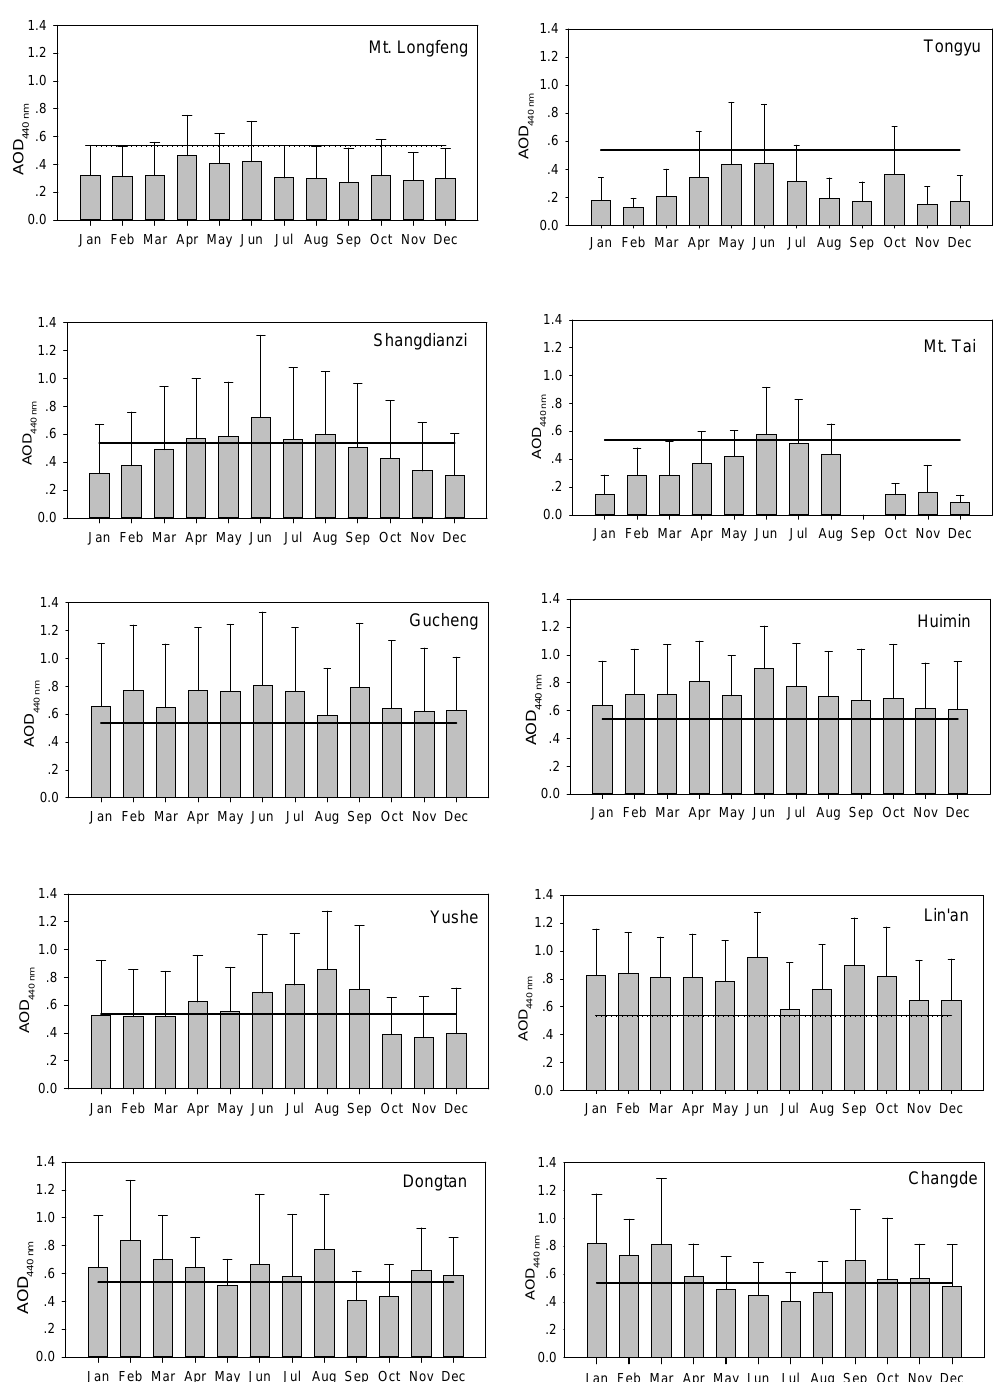
Figure 12. Monthly averaged AODs at 440nm at rural central and eastern China sites. The solid and dash horizontal hairlines indicate the annual averages for the subgroup and the whole database,